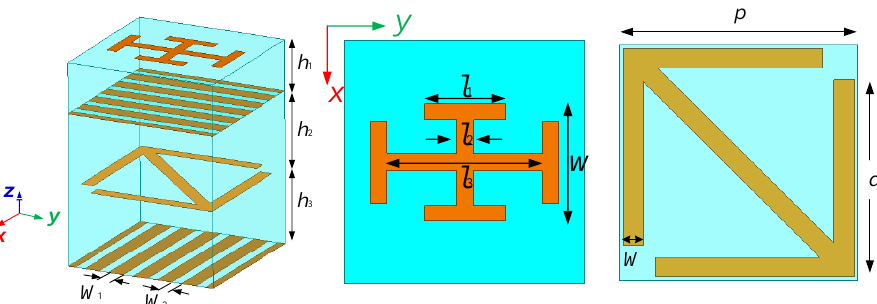
( b ) Figure 3. Simulation results of the element: ( a ) Transmission amplitude; ( b ) Transmission phase. According to the simulation results in Figure 3, the element has very good transmis- sion performance in broadband. However, when the y -polarized wave is incident along